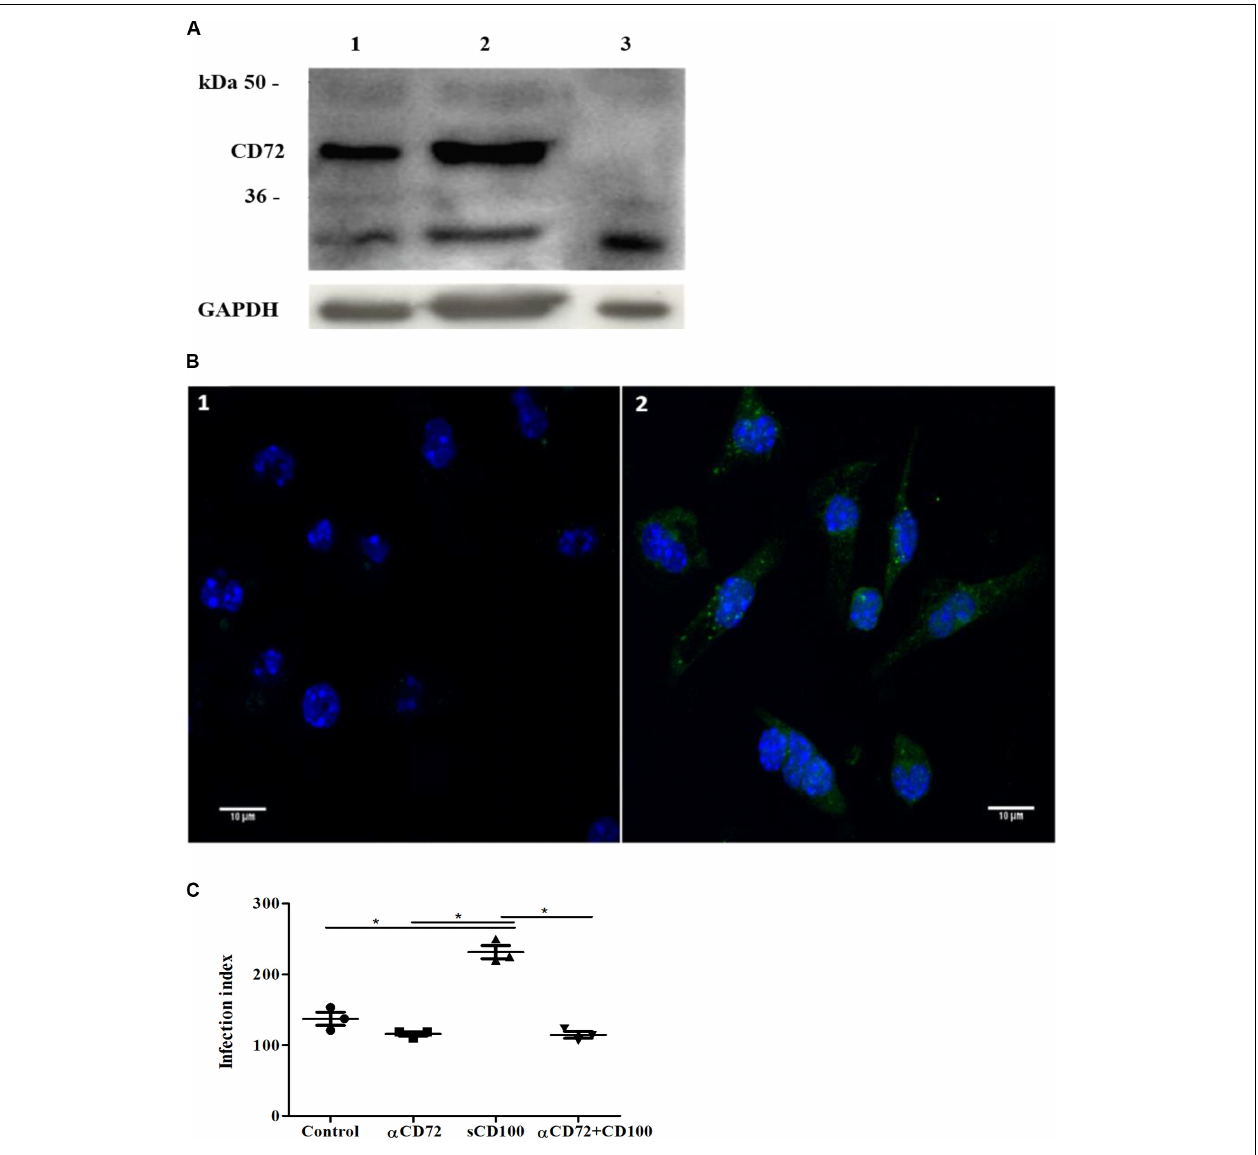
FIGURE 5 | Expression of CD72 and its role in sCD100 effects on macrophages. (A) Western blot showing expression of CD72 and GAPDH in peritoneal macrophages from BALB/c mice (lane 1), macrophage incubated with 200 ng/mL of sCD100 for 48 h (lane 2) and L929 cells (negative control - lane 3). Thirty micrograms of protein extracts were analyzed in 10% SDS–PAGE. (B) Immunofluorescence staining for CD72 in peritoneal macrophages from BALB/c mice: control incubated with anti-rabbit Alexa Fluor 488 secondary antibody and DAPI (image 1), macrophages incubated with anti-CD72, anti-rabbit Alexa Fluor 488 secondary antibody and DAPI (image 2). Images were captured in Zeiss LSM 780-NLO confocal microscope, magnifying 63 × , 1.0 zoom. (C) Infection index of macrophages from BALB/c mice in the presence or absence of sCD100, preincubated or not with anti-CD72 for 48 h. Data represent means and standard deviations of one experiment with triplicates. Statistical analysis was performed by ANOVA followed by Tukey’s post-test, and significant differences are labeled as ∗ p ≤